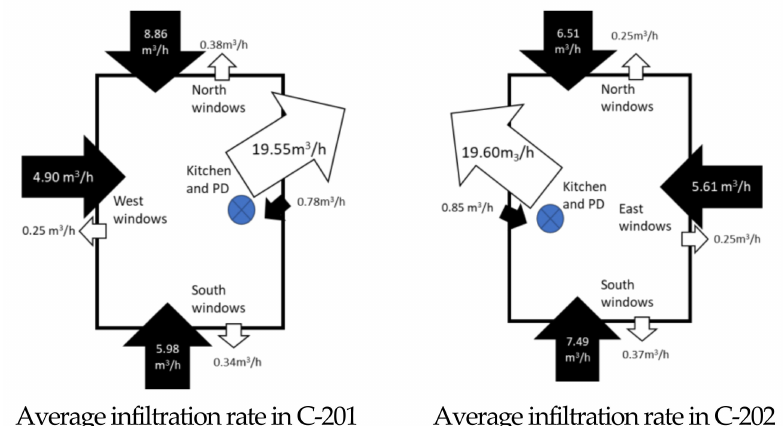
Figure 10. Infiltration rate through each crack in C-201 and